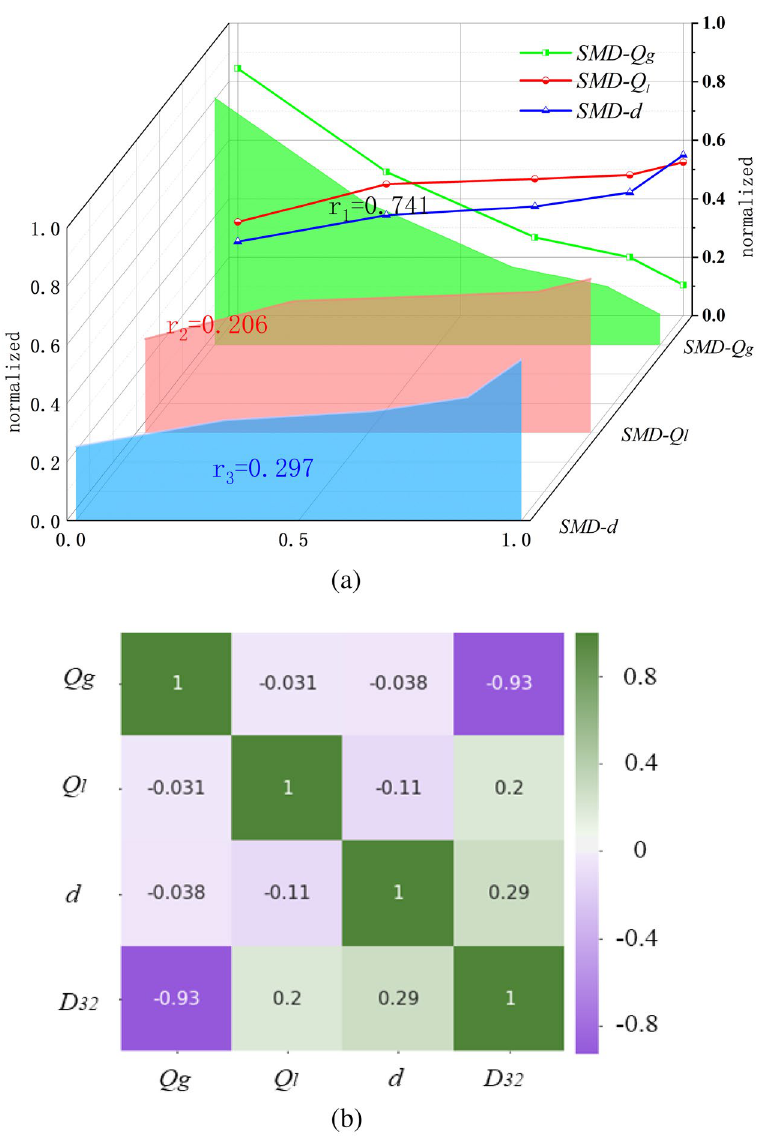
Figure 11. Sensitivity of each input parameter to the normalized SMD of the BP network. ( a ) Standard normalization. ( b ) Correlation coefficient matrix